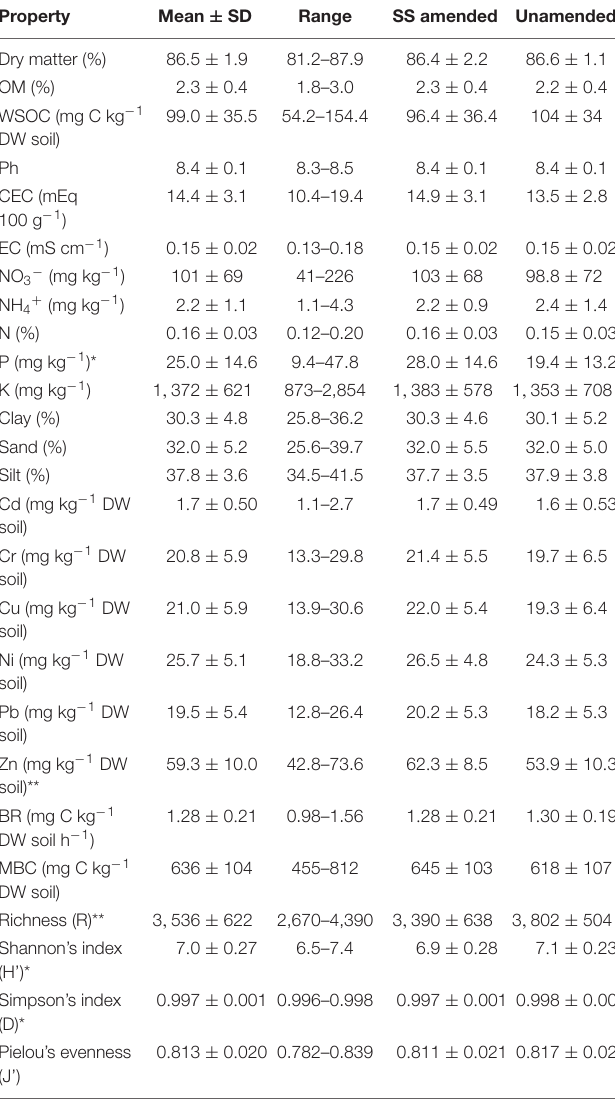
TABLE 2 | Physicochemical and microbial properties of the 20 agricultural soils.